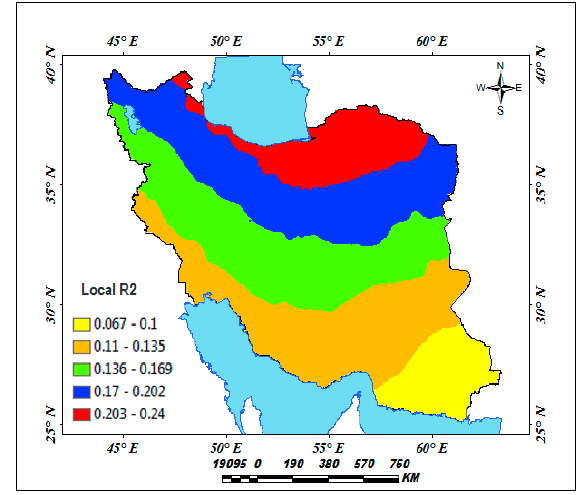
Figure 26. Local R (cid:2870) of the GWR model.